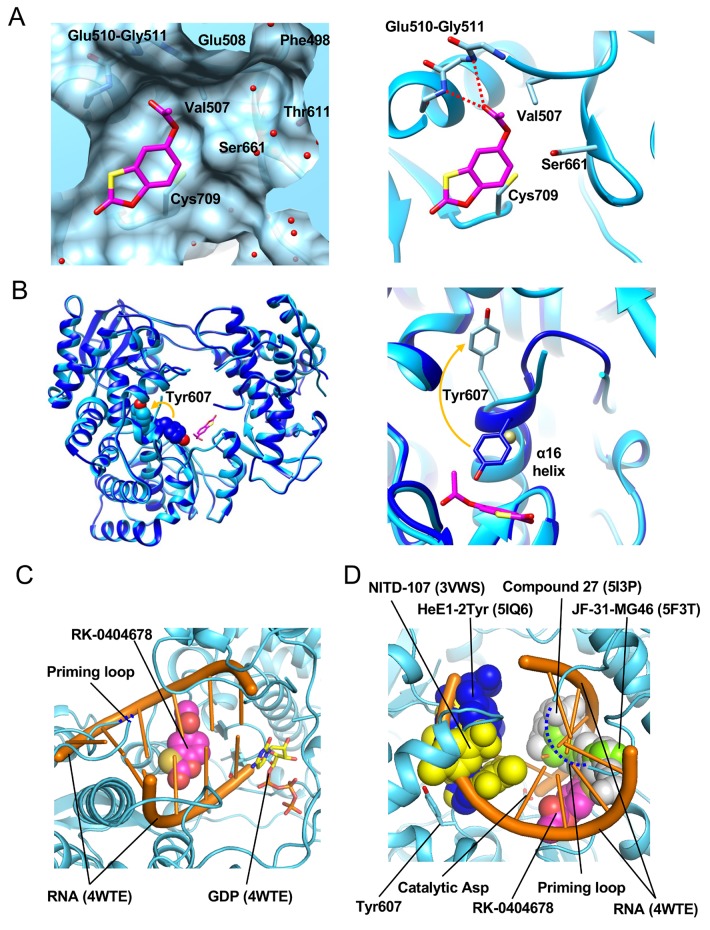
Details of the interaction between the DENV2 RdRp and RK-0404678 in Site 2.A. Surface (left) and ribbon-stick (right) representations of the interaction between the DENV2 RdRp and RK-0404678 in Site 2. RK-0404678 is represented by a magenta stick model. The water molecules and hydrogen bonds are represented by red spheres and dotted lines. B. Structural comparison of Tyr607 between the RK-0404678-bound (light blue) and apo (blue) forms. Overall structures (left) and close-up view (right). The side chains of Tyr607 are represented by CPK (left) and stick models (right), and the cobalt atom is represented by a gold sphere. C. Site 2 in the active site of the RdRp. The RK-0404678 molecule (magenta) is represented by a CPK model. The RNA strands (orange) and GDP (stick model) of the HCV RdRp structure (PDB ID: 4WTE) are superimposed on the DENV2 RdRp structure. The priming loop, which is not visible in the DENV2 RdRp structure, is represented by a blue dashed line. D. Overlay of the previously reported DENV inhibitors in the active site of the RdRp. The RK-0404678 molecule (magenta), the previously reported inhibitors (PDB IDs: 5I3P (grey), 5F3T (light green), 3VWS (blue), 5IQ6 (yellow)), and the RNA strands and GDP (PDB ID: 4WTE, orange) are superimposed on the DENV2 RdRp structure. The priming loop is represented by a blue dashed line.